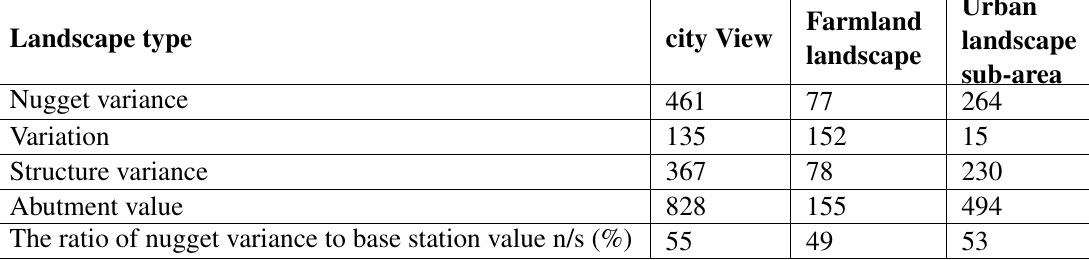
Fig. 7 Semivariance of farmland landscape experiment Table 2 Theoretical semivariance parameters of the experimental semivariance fitting for each landscape